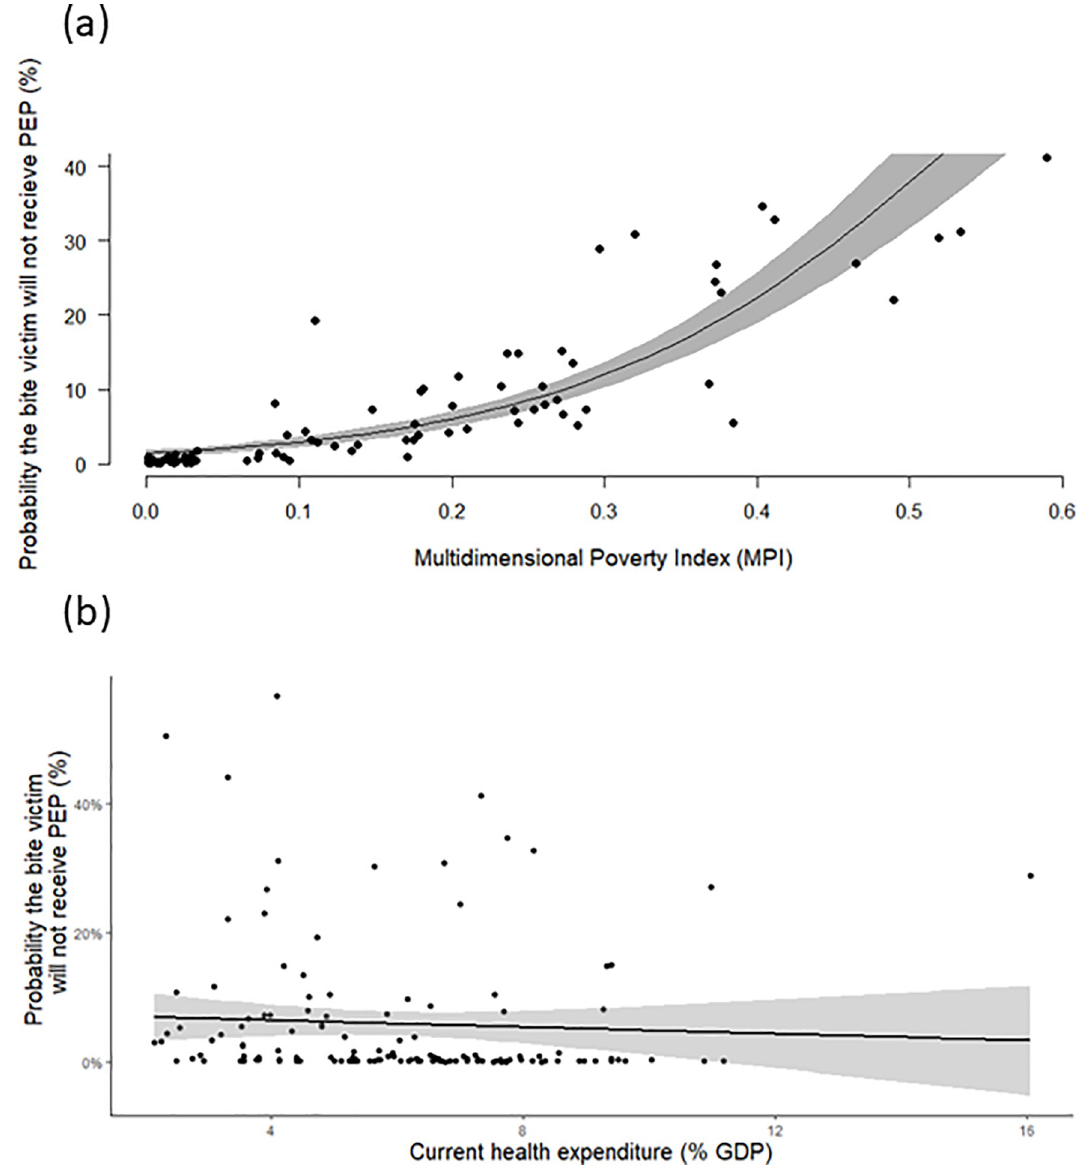
Fig 4. (a) Results from Generalised Linear Model using Quasibinomial distribution for current health expenditure (% GDP) from 2020, and probability of bite victims receiving PEP from 2015, in 98 countries where data were available. (b) Results from Generalised Linear Model for Multidimensional Poverty Index from 2020, and probability of bite victims not receiving PEP from 2015, in 98 countries where data were